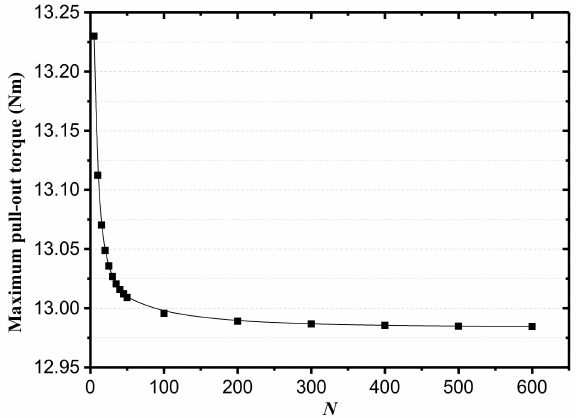
Figure 9. Influence of N on the analytical calculation